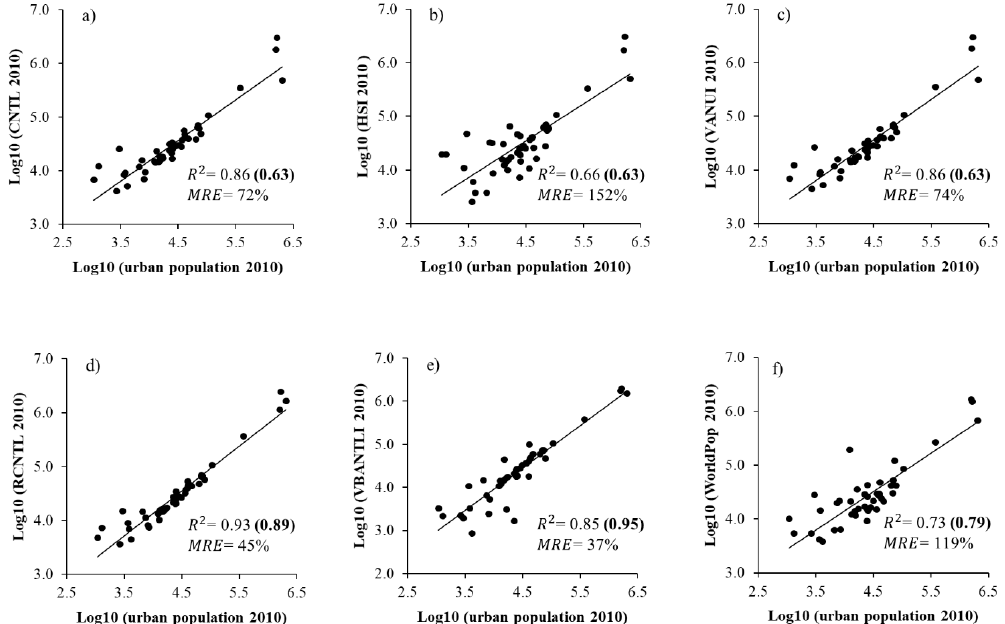
Figure 7. Validation of the simulated population in 2010 using ( a ) CNTL, ( b ) HSI, ( c ) VANUI, ( d ) RCNTL, ( e ) VBANTLI and ( f ) WorldPop.